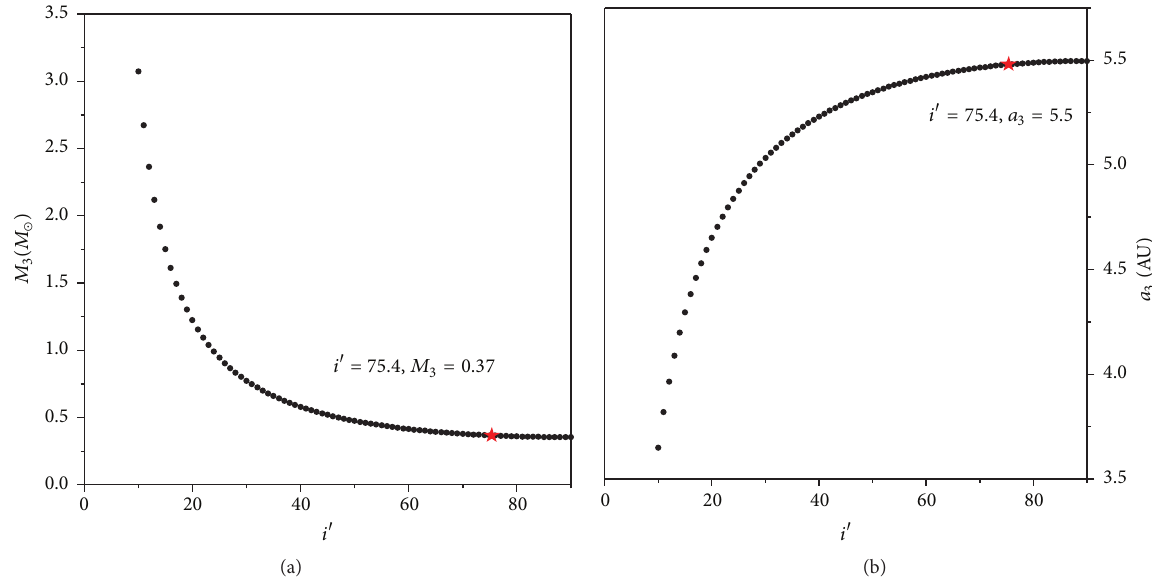
Figure 4: The relationship between 𝑖 󸀠 and 𝑀 3 (a). The relationship between 𝑖 󸀠 and 𝑎 3